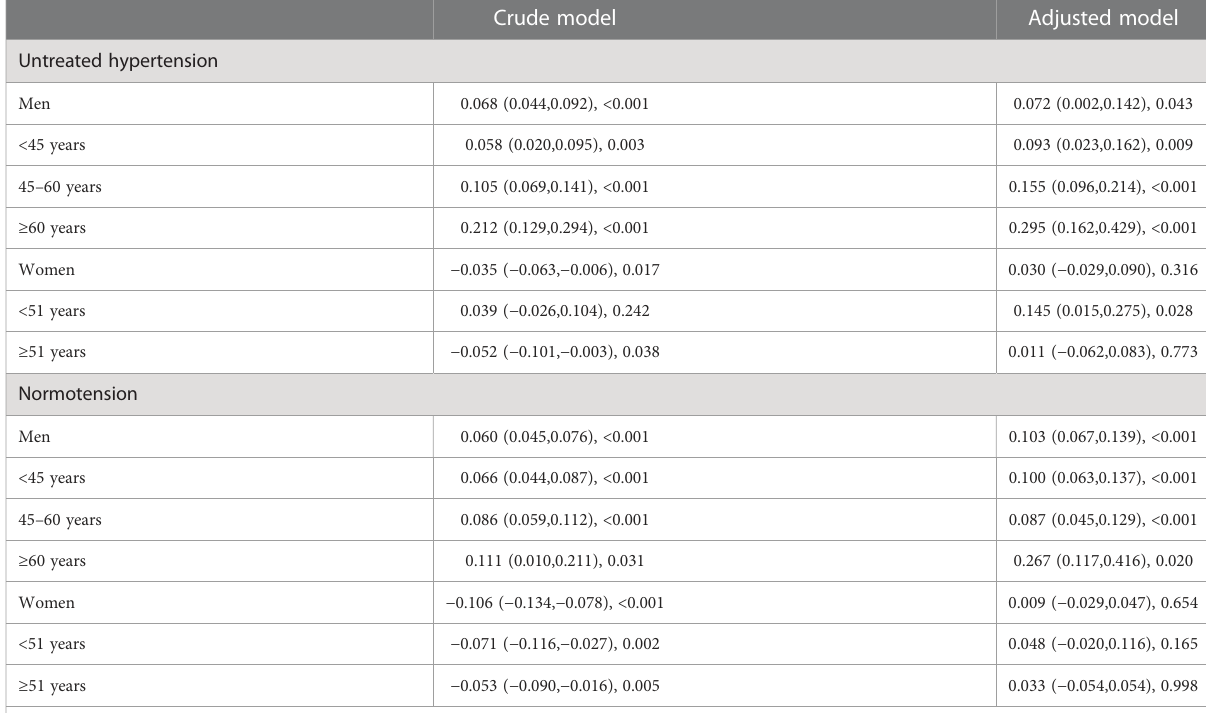
TABLE 6 Liner regression for the relationship of log No-SAS score with and log plasma aldosterone concentration in total, men, and women participants by presence of hypertension and by age in community-based participants (B, 95%CI, p). Crude